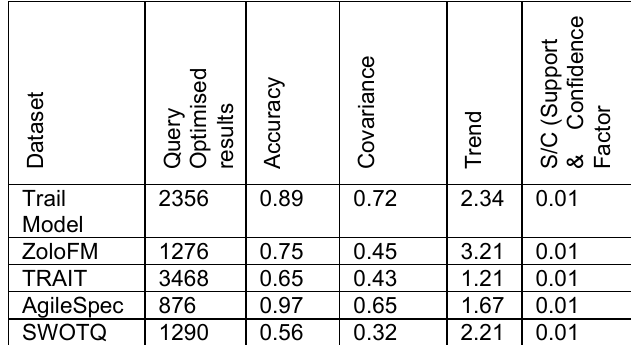
Table 2. Arrival dataset information processing results using the Autoregression